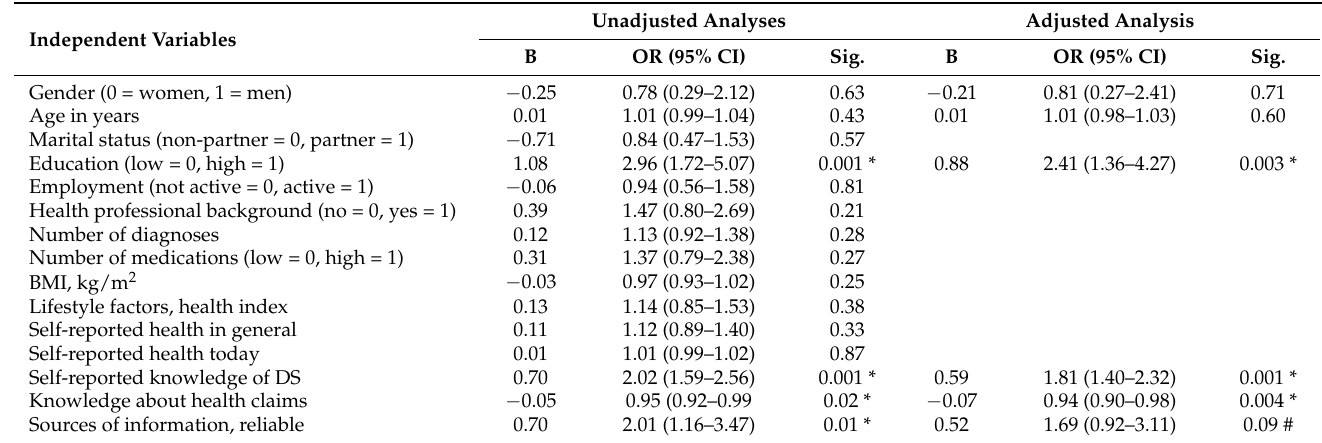
Table 7. Unadjusted and adjusted logistic regression models of the strength of relationships between the users and non-users of DS and variables measuring demographics, lifestyle factors, health conditions, and knowledge of